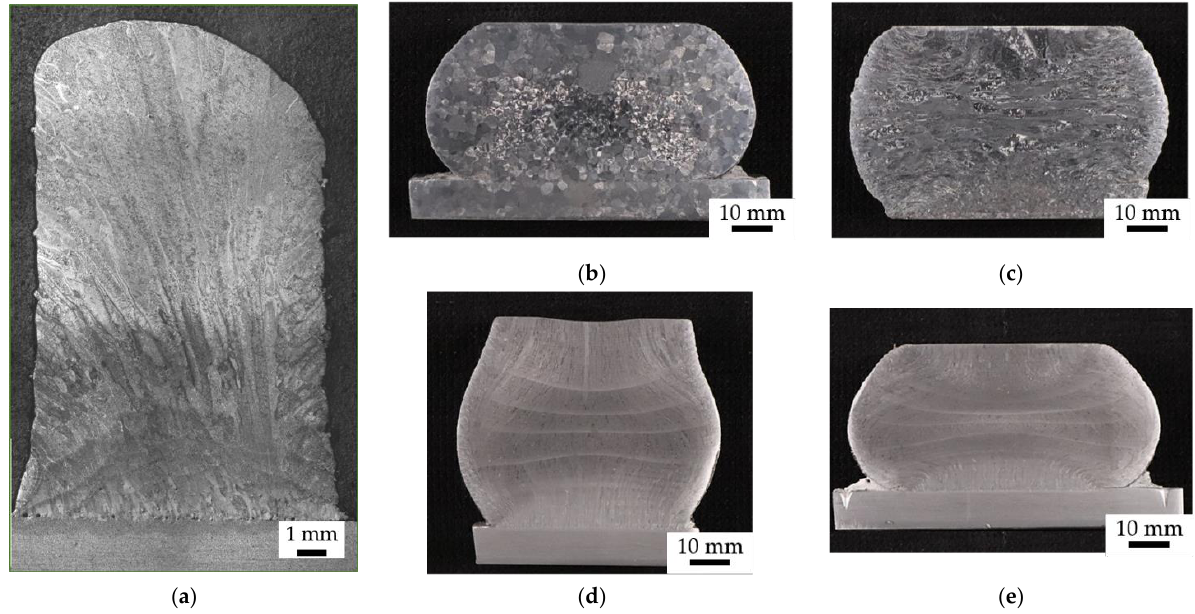
Figure 4. ( a ) L-DED as-built sample, prior to hot deformation; ( b–e ) macrostructures of forged samples: ( b ) after alpha-beta forging to a compression of 50%, followed by beta annealing; ( c ) after beta forging to 50% compression, followed by stress relief annealing, ( d ) after alpha-beta forging to 25–30% compression, followed by stress relief annealing and ( e ) after alpha-beta forging to a compression of 50%, followed by stress relief annealing.